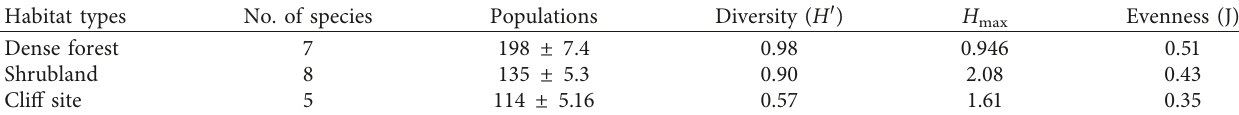
Table 6: The mammalian species diversity ( H ′ ) and evenness ( J ) in different habitat types in Tiski waterfalls.